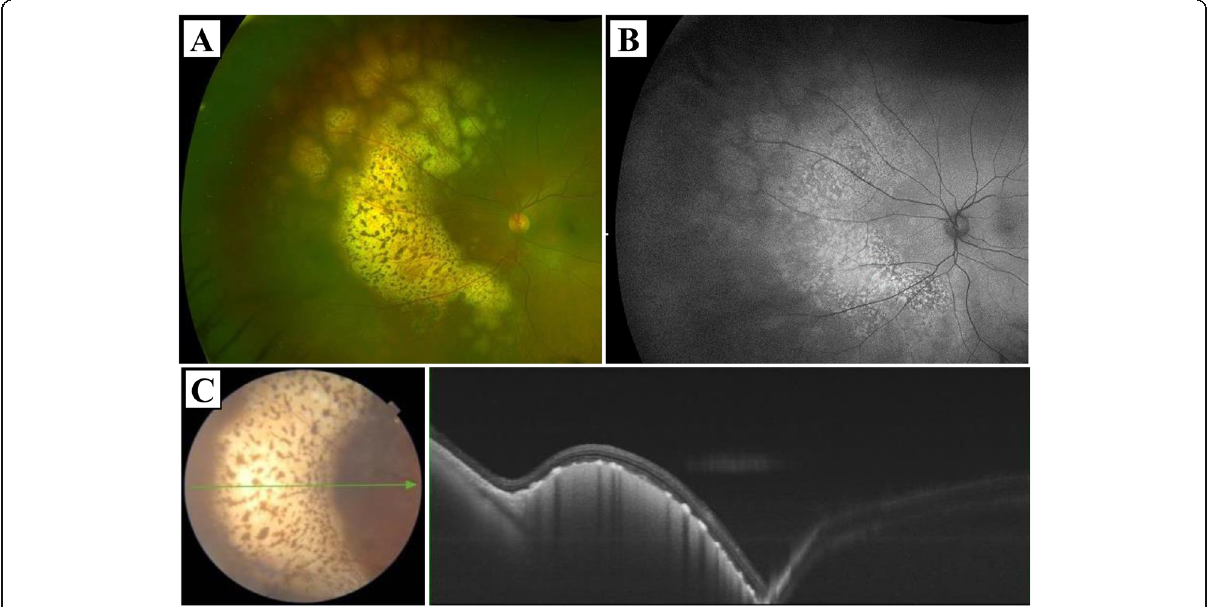
Fig. 1 Imaging findings of the left eye at the first visit. (A) Fundus photograph showed a yellowish-white raised patchy lesion at the nasal fundus of the left eye. (B) In fundus autofluorescence imaging, a mixture of hyperfluorescence and hypofluorescence was observed at the same site. (C) Optical coherence tomography depicted lesions below the retinal pigment epithelium. The image was acquired along the green